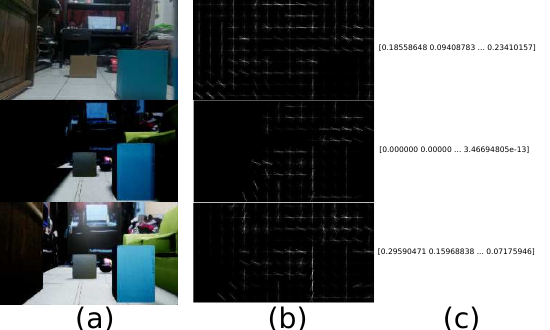
Figure 4. Real-world and virtual samples with different levels of details. ( a ) Samples in different domains, ( b ) the gradient generated by the HOG algorithm, and ( c ) the vector generated by the HOG